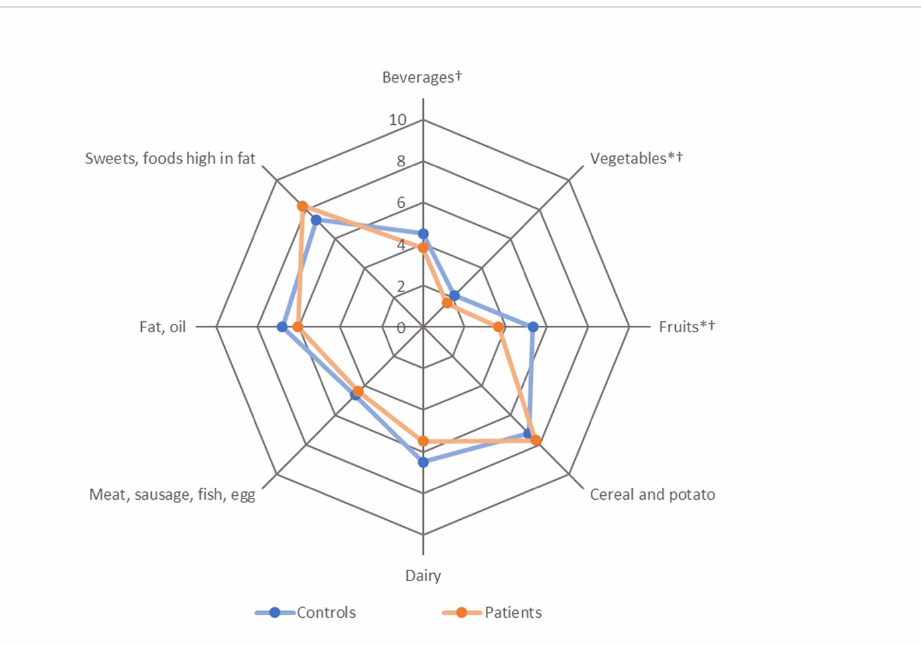
Figure 3. Dietary patterns of patients and controls according to average scores achieved for the items of the Healthy Eating Index (HEI). Note. Scores ranged between 0–10 or 0–20 points depending on the item. † maximum points downscaled from 20 to 10 points. * p < 0.05. Detailed numerical results are presented in Table